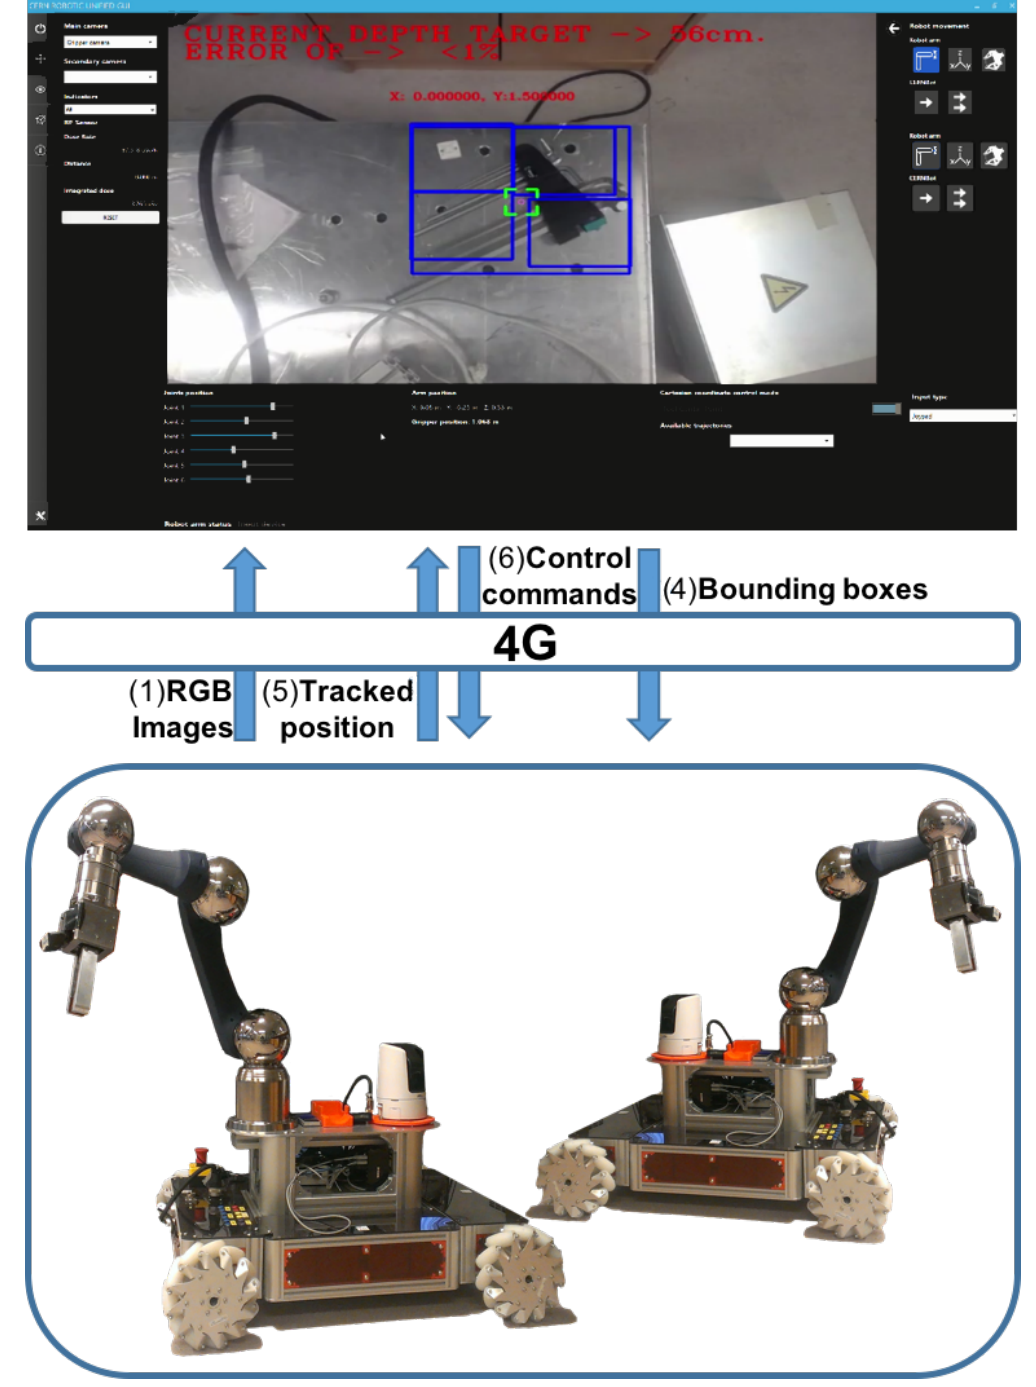
Figure 24. Tracking system for safe grasping of metallic objects in a real